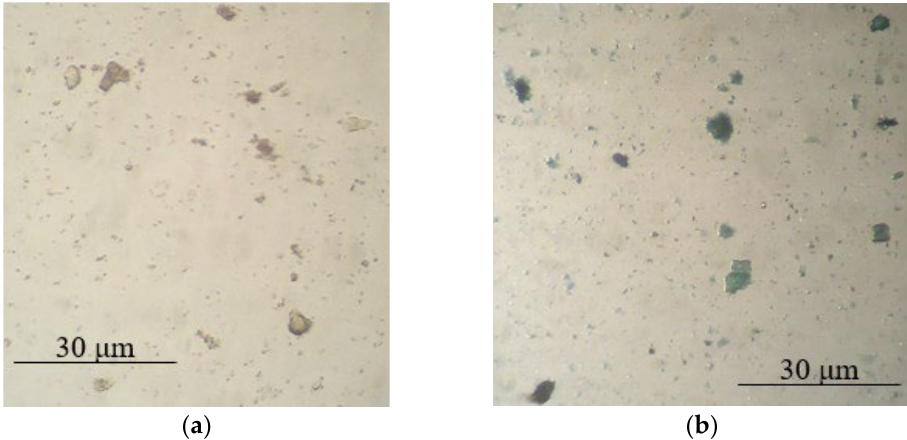
Figure 2. Micrographs of kaolin ( a ) and core/shell pigment with a kaolin core ( b ) (20 wt.% of PANi, sulfuric acid used as a dopant).